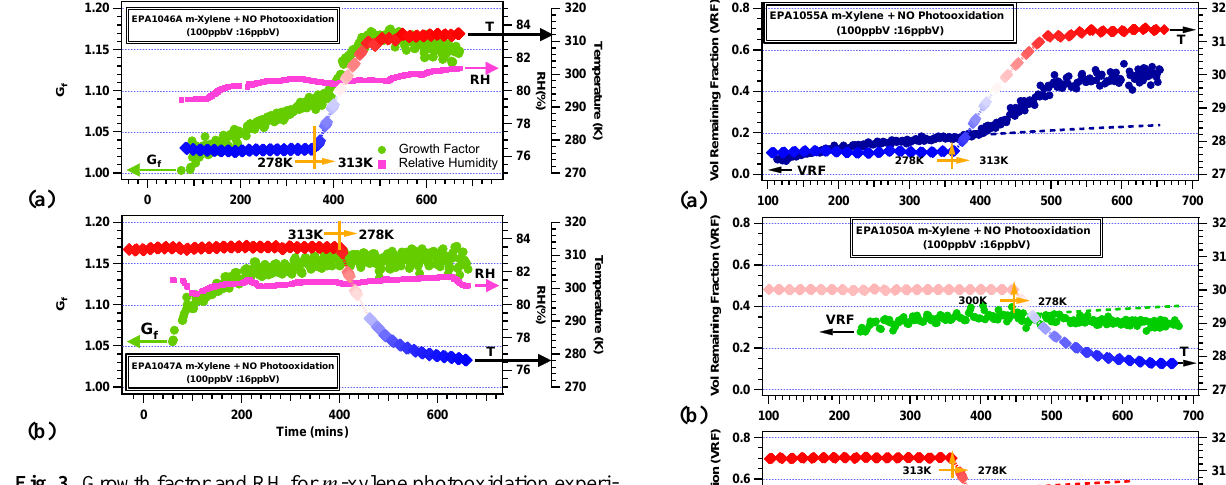
of molecules by the vaporizer, most of the signal inten- sity in the HR-ToF-AMS occurred below mass to charge ra- tio ( m/z ) 100; parent molecular peaks were weak or unob- served. Therefore, m/z values of fragment ions were in- terpreted as tracers of the parent species and the change in contribution fraction of signal intensities could be attributed to evolution of aerosol species (e.g., change in signal in- tensity ratio of m/z 44/43). For instance, m/z 44 is com- monly associated with fragments of oxo- and dicarboxylic ) while m/z 43 is a fragment normally associ- acids (CO + 2 ated with oxidized organic molecules containing carbonyl groups (C 2 H 3 O + ) (Alfarra et al., 2006). The average mass spectra of organics normalized to the total organic signal are displayed in Fig. 5. The same fragmentation table was used as that in Aiken et al. (2008). When the reaction starts ) is 6.5% at 278 K, the relative intensity of m/z 44 (CO + 2 and then increases to 8.4% when the system temperature reaches 313 K. However, when the reaction starts at 313 K and then cooled down to 278 K, the contribution fraction of CO + ion is considerably higher and only changes from 2 10.0% to 9.7%. These results indicate that for this system the SOA produced at cold temperatures are less oxygenated than those produced at higher temperatures and that less oxy- genated species are preferentially lost from the aerosol as the system is heated. The change in m/z 44 relative in- tensity upon heating is attributed to evaporation of lighter- end semi-volatile species that may be less